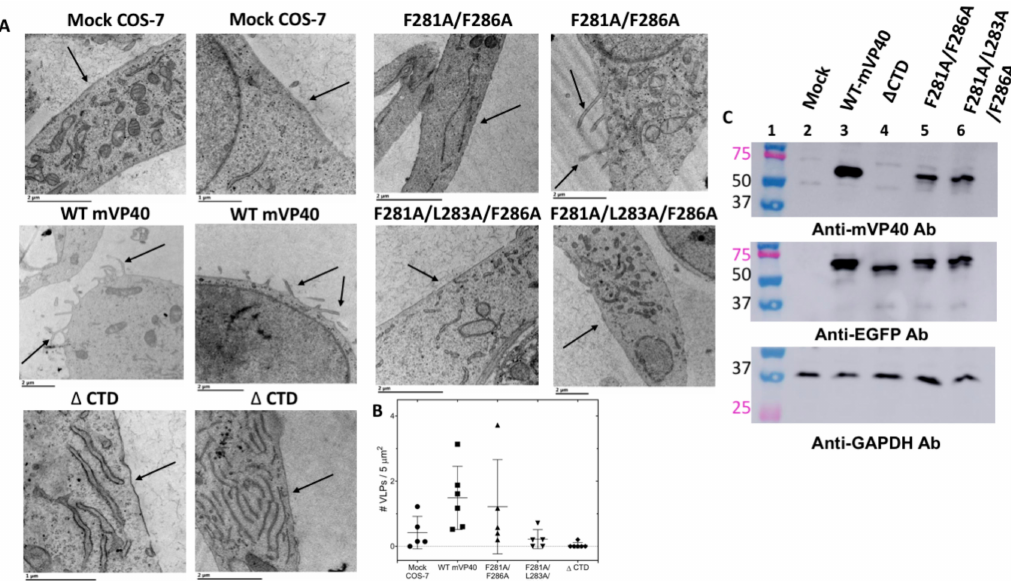
Figure 4. TEM and heterologous expression test of mVP40 and hydrophobic mutants. ( A ) Morphology of cells expressing WT mVP40 or mutant proteins. TEM images of COS-7 cells transfected with EGFP fusion constructs of WT-mVP40, F281A / F286A, F281A / L283A / F286A, or the CTD deletion. Arrows point to regions of the plasma membrane were formation or absence of pre-VLPs is evident for each respective construct. ( B ) To estimate the number of VLPs per area, the area of each cell was measured and the number of pre-VLPs (* only counted VLPs visibly connected to the plasma membrane surface) were counted. In the graph, values are reported as mean ± SD where a Brown-Forsythe and Welch ANOVA was then performed with multiple comparisons (compared to WT mVP40). p = 0.047 for CTD and p = 0.076 for F281A / L283A / L286A. ( C ) Expression of WT mVP40 and mutant proteins in COS-7 cells. Cell lysates collected from cells that were mock transfected (lane 2), expressing WT-mV40 (lane 3), or mutant mVP40 proteins (lanes 4–6) and were assessed by SDS-PAGE electrophoresis and western blot analysis by using anti-mVP40 antibody, anti-EGFP antibody and a control anti-GAPDH antibody. A ladder with molecular weight labeled was included in lane